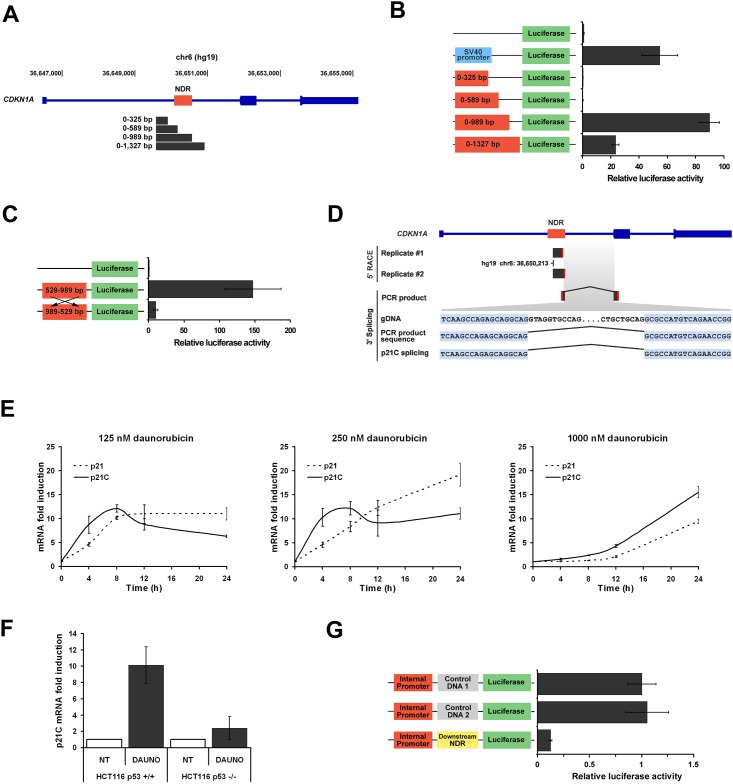
The CDKN1A stress-dependent chromatin loop controls the interaction between a CDKN1A alternative internal promoter and a downstream repressor element.(A) CDKN1A gene with the DNA fragments spanning the CDKN1A nucleosome-depleted region (NDR) cloned for the luciferase assay. Base counting starts at position chr6:36,649,572 strand (+) hg19. (B) Luciferase reporter assay to measure the promoter activity of the CDKN1A NDR. Signal was normalized to the empty vector. (C) Luciferase reporter assay to test the directionality of the putative promoter. Signal was normalized to the empty vector. (D) Experiments to locate the TSS and the 3’ splicing junction of the mRNA transcribed from the internal promoter. The 5’ RACE products from two biological replicates obtained using two different sets of primers were sequenced and aligned to the CDKN1A gene (S9 Table). The 3’ splicing was determined by performing a PCR on cDNA using a forward primer overlapping the 5’ RACE product and a reverse primer located on exon 2 of p21. The sequencing results of the PCR are shown along with the p21C splicing sequence. Experiments were performed in HCT116 p53+/+ cells treated with daunorubicin. Red rectangles correspond to primers. (E) p21 and p21C mRNA levels assayed by RT-qPCR in HCT116 p53+/+ cells exposed to 125, 250, or 1000 nM daunorubicin and collected over a 24 h time course. (F) p21C mRNA level assayed by RT-qPCR in HCT116 p53+/+ and p53-/- cells exposed to 250 nM daunorubicin for 8 h. (G) Luciferase reporter assay to test the repressor activity of the interacting region on the CDKN1A internal promoter. The luciferase signal is normalized to Control DNA1.